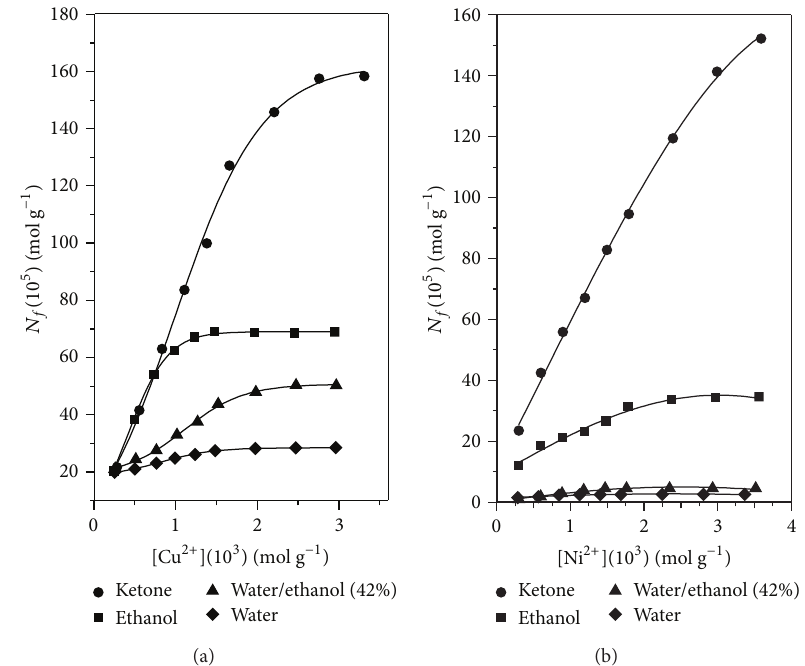
Figure 6: Adsorption isotherms of copper (a) and nickel (b) ions from solutions on SGAPC at 25 ∘ C.